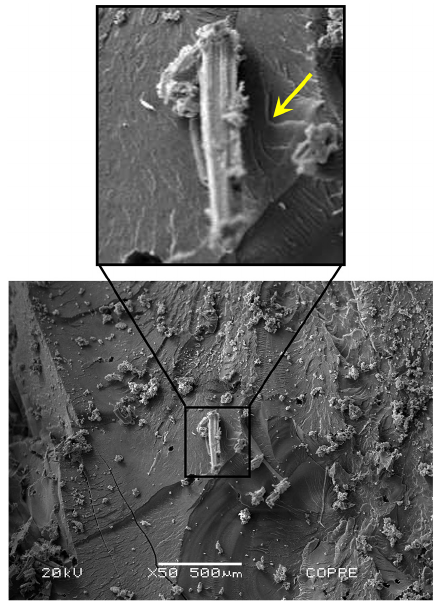
Figure 10. Low magnification SEM fractograph of bend tested epoxy matrix composite reinforced with 30 vol% of malva